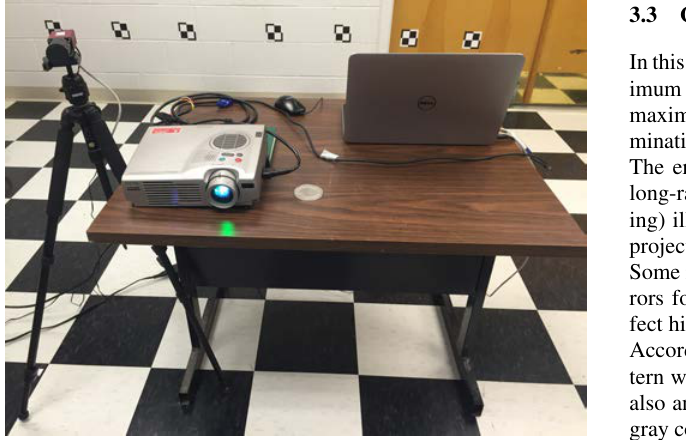
method is that the projector and camera are calibrated together with simple procedures.